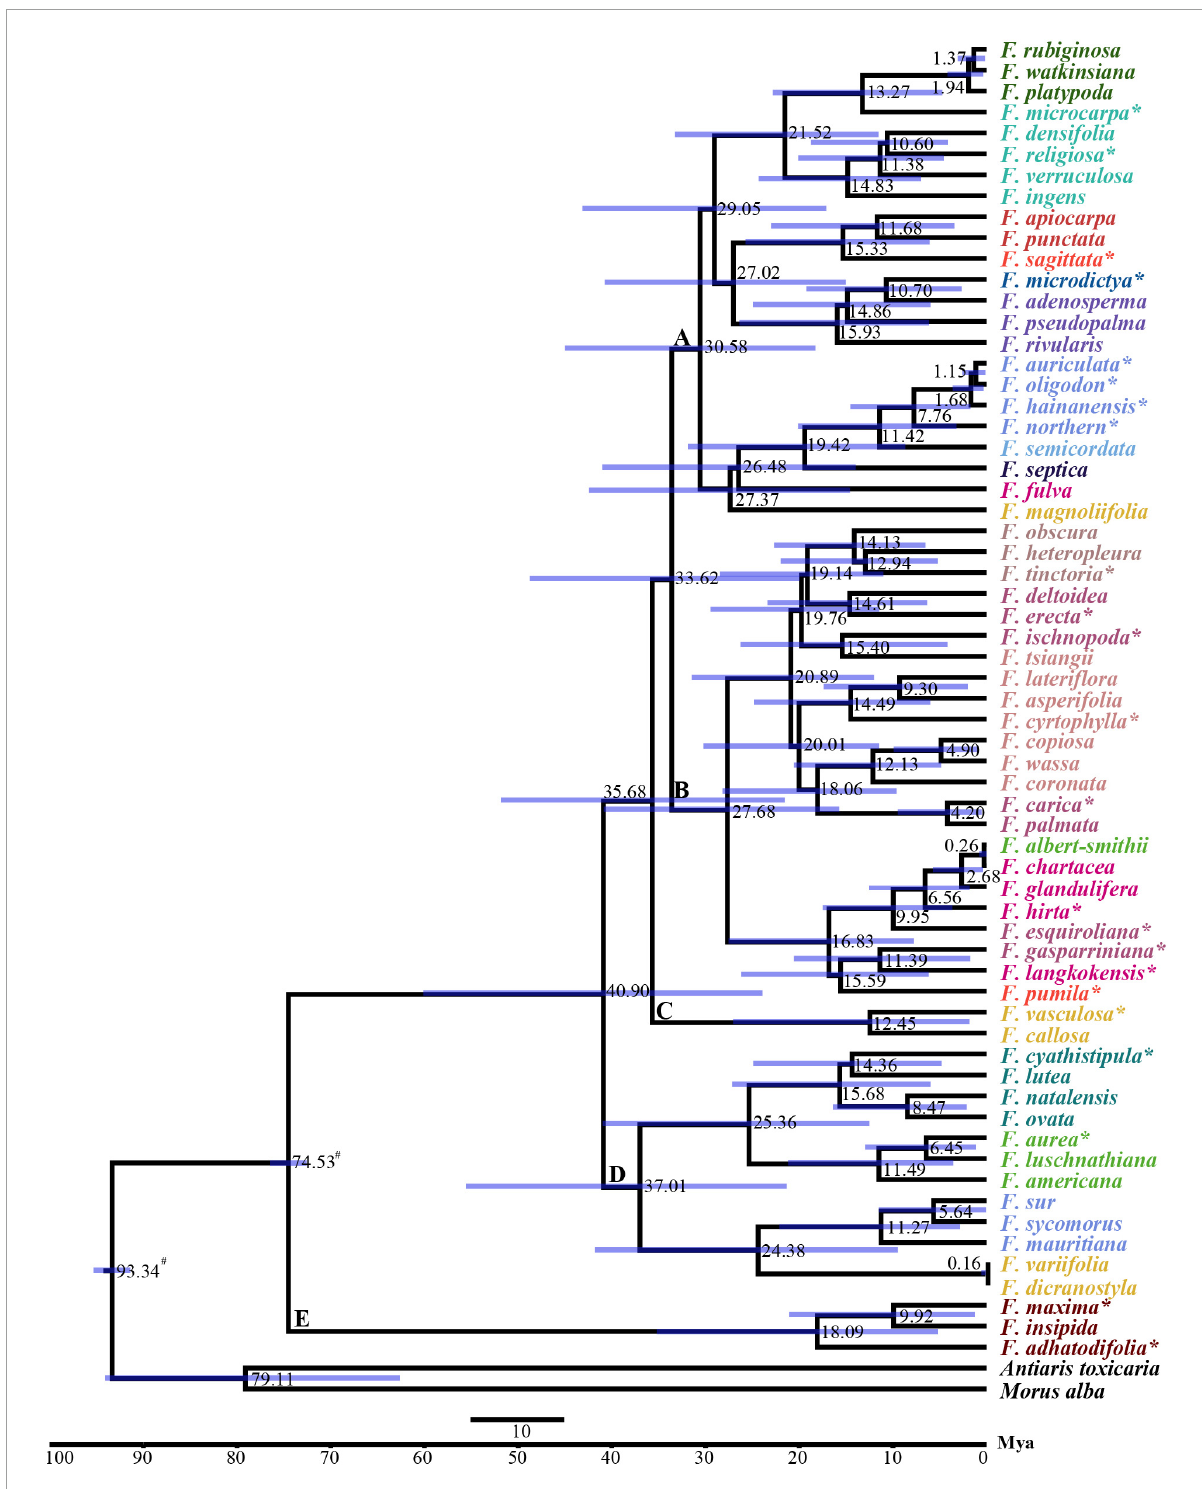
FIGURE4 BEAST chronograms of the evolutionary history of Ficus using Yule model. The mean divergence time of the nodes was shown next to the nodes while the blue bars correspond to the 95% highest posterior density (HPD). # Indicates the calibration points, ∗ indicates the chloroplast was obtained in this study, the other 40 Ficus species were downloaded from Bruun-Lund et al.